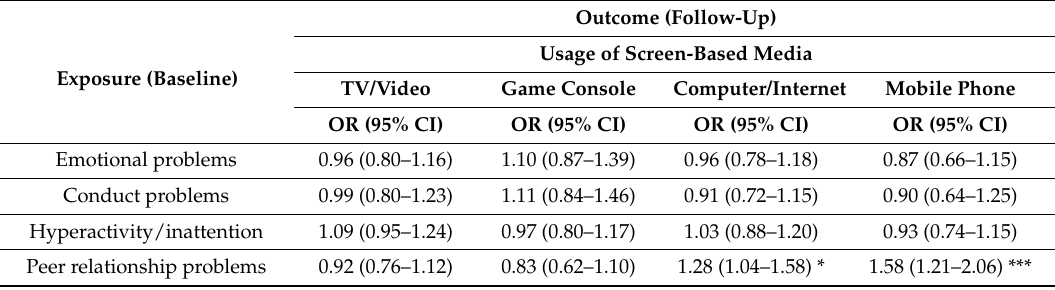
Table 3. Association of behavioral difficulties at baseline with electronic media usage at follow-up (N = 537) a